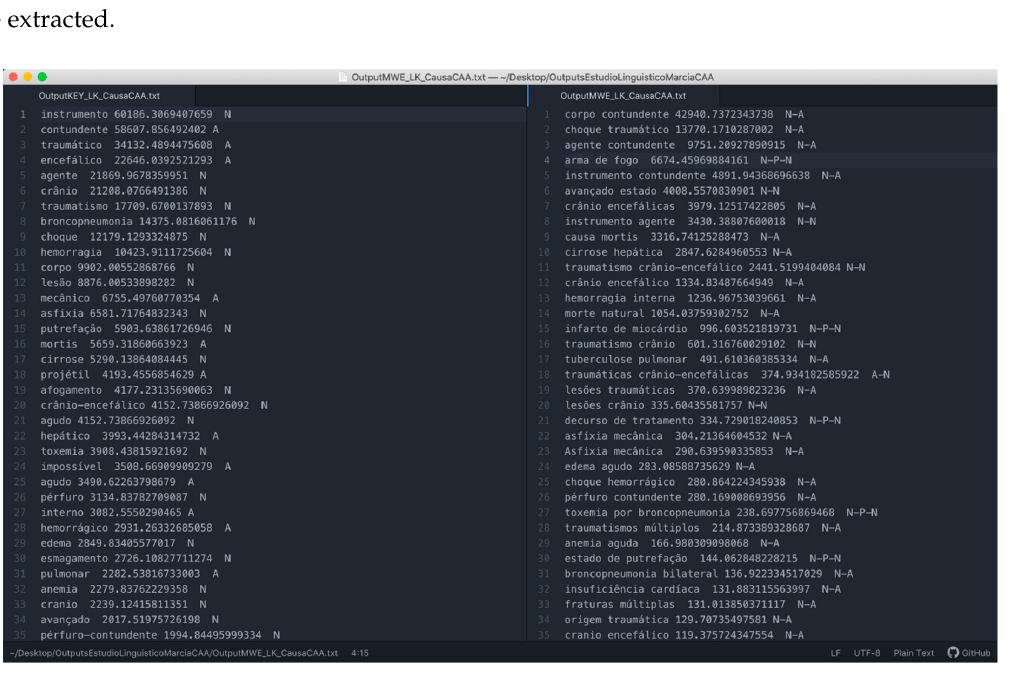
Figure 4. Linguakit output for keywords and multiword analysis of causes of death in the ‘Disappearances in São Paulo’ corpus.